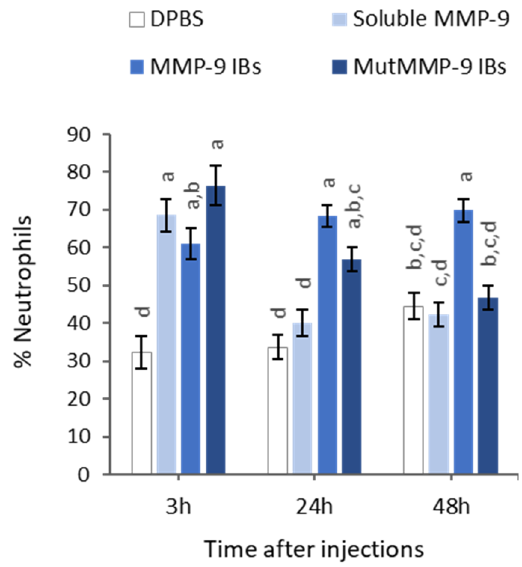
Figure 4. Relative quantification of neutrophils among total immune cell populations by cytospin centrifugation of exudates recovered after 3, 24, and 48 h after intradermal injection of Sb MMP-9, MMP-9 IBs and mutant MMP-9 IBs in air-pouches of mmp9 KO mice. Percentages are relative to 100 cells counted by triplicate for each sample. Means and SEM from non-transformed data are represented. Different letters depict significant differences ( p < 0.0001). Data were analyzed, using a fixed effect model with treatment and time as fixed effects ( n = 12 (3 h), n = 24 (24 h), n = 24 (48 h)).